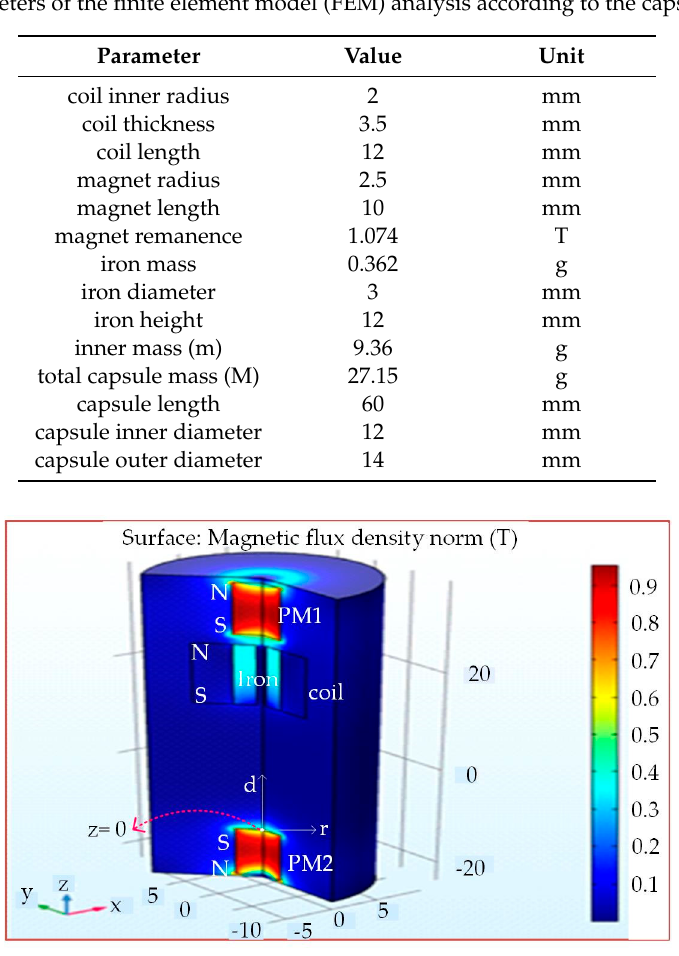
Table 1. Parameters of the finite element model (FEM) analysis according to the capsule prototype.